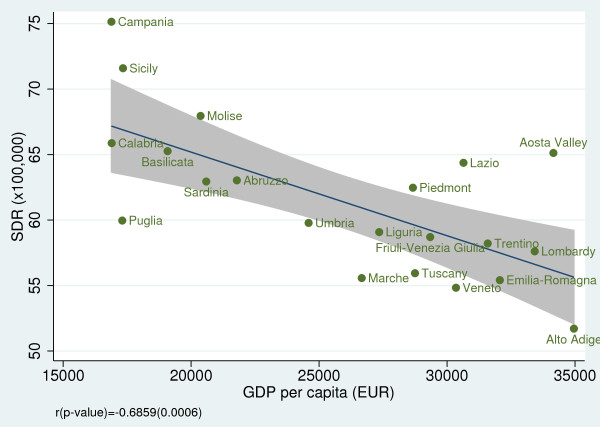
Amenable mortality vs. GDP per capita for the year 2008. Data source: Rapporto Osservasalute 2011 [16].